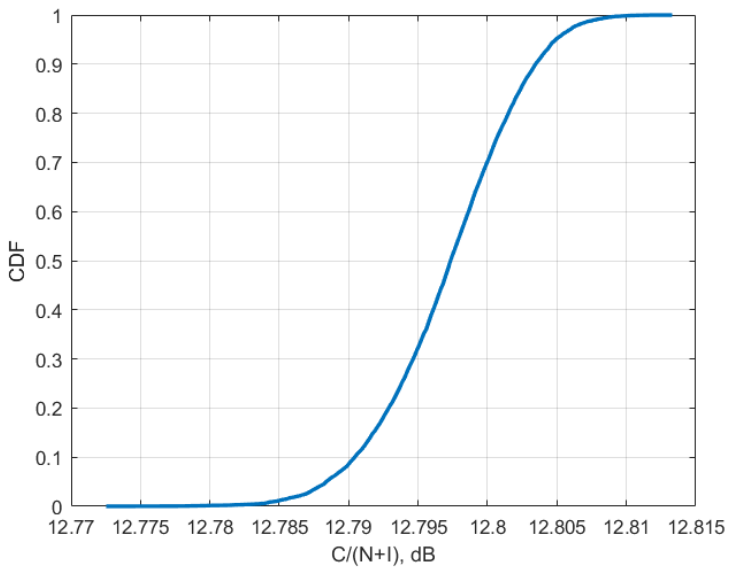
Figure 10. Cumulative distribution function of C/(N+I) for transponder Yama; 183E for 6/4 GHz.